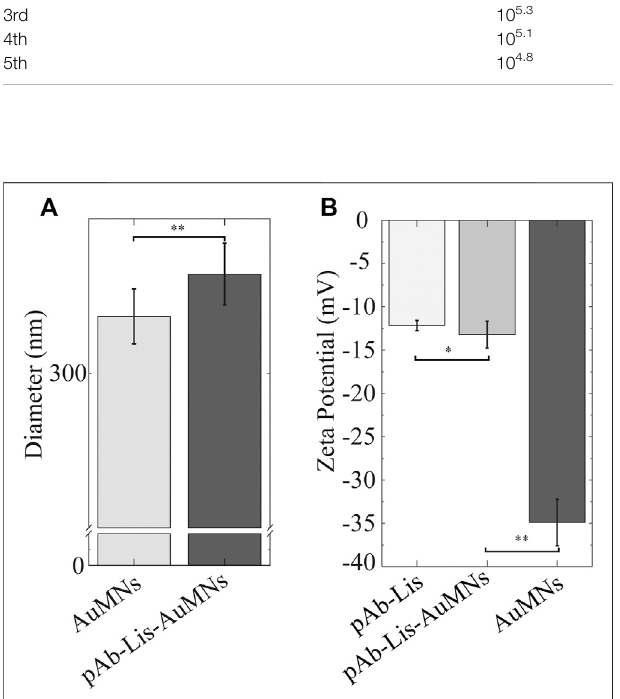
FIGURE 5 | (A) DLS particle size change using effective diameter exhibits a 99% con fi dence t -test suggesting statistically signi fi cant change in effectivediameter. (B) ζ -potential exhibitssigni fi cance with95%con fi denceof equivalence utilizing the TOST test between the pAb-Lis and the